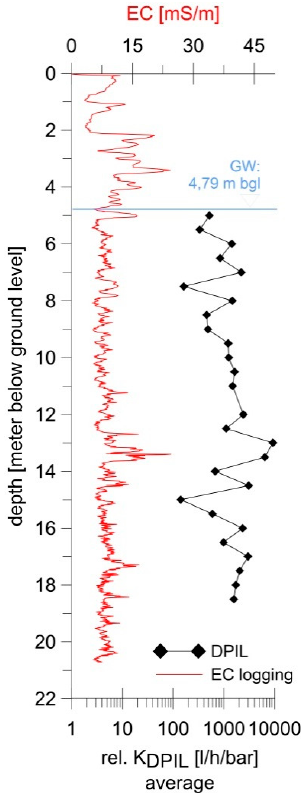
Figure 8. Direct Push profiling results (DPIL and Electrical Conductivity measurements).